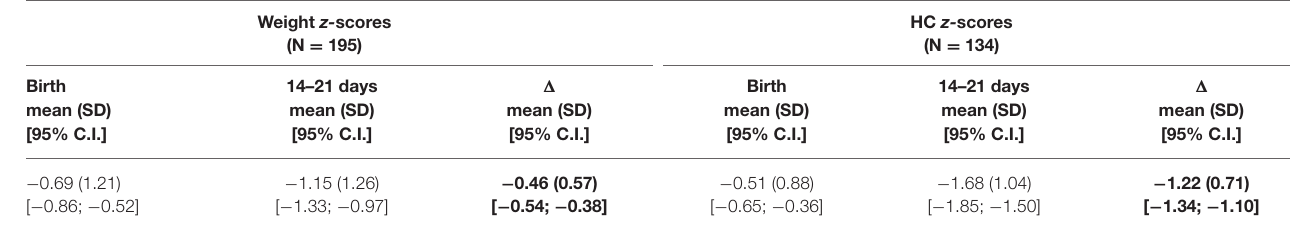
TABLE 2 | Weight and HC z- scores differences between birth and 14–21 days of life. Weight z- scores (N = 195)